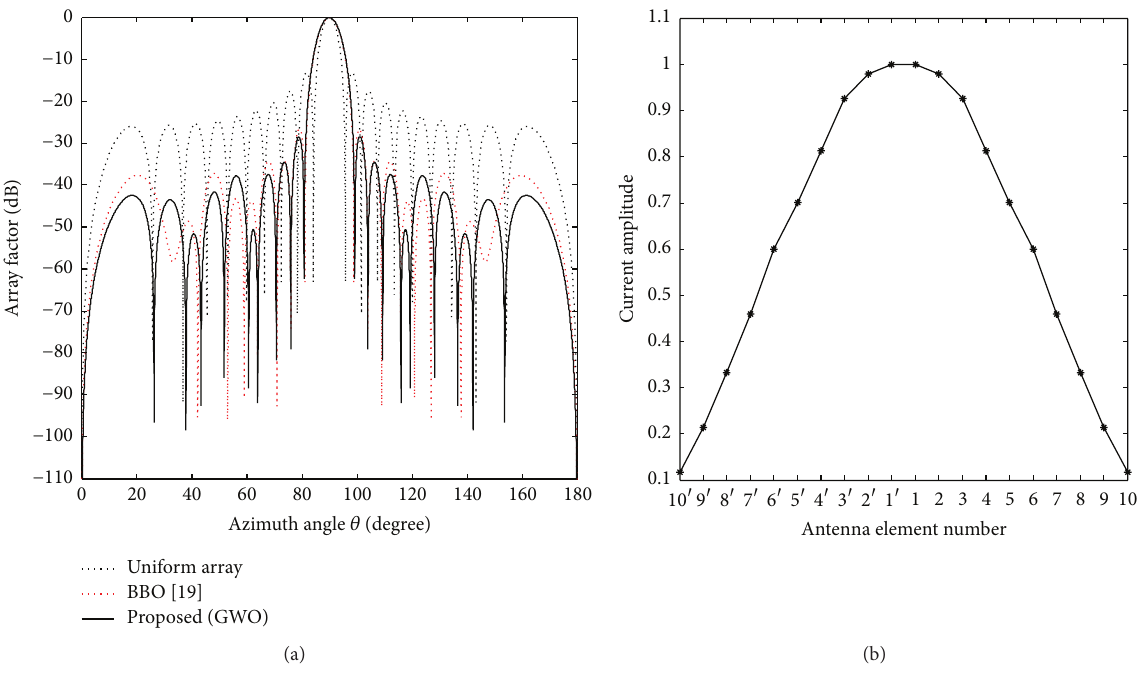
Figure 10: Example 7: (a) array pattern and (b) current